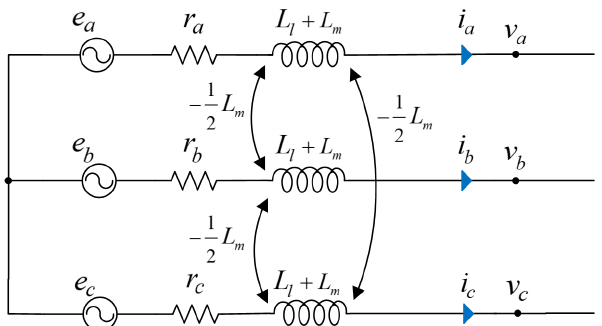
Figure 2. PMSG model in the abc reference frame